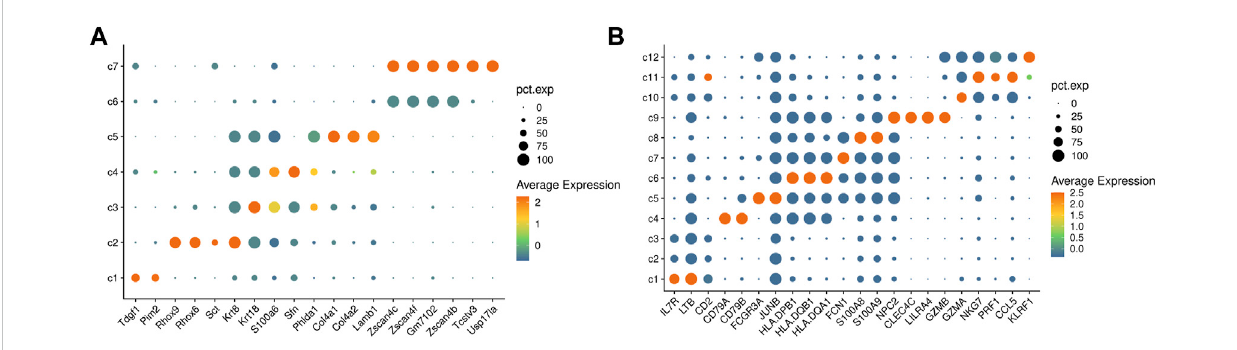
FIGURE 6 Resultsfromrealdataanalysis. (A) Aheatmapofdifferentiallyexpressedgenesfortheclusteringresultsofthemouseembryonicstemcellsdata. (B) A heatmap of differentially expressed genes for the clustering results of PBMC 4k